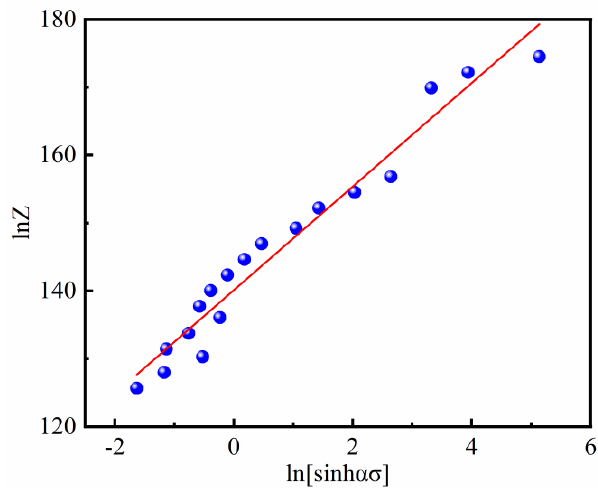
Figure 7. Relationship between the Z parameter and flow stress.